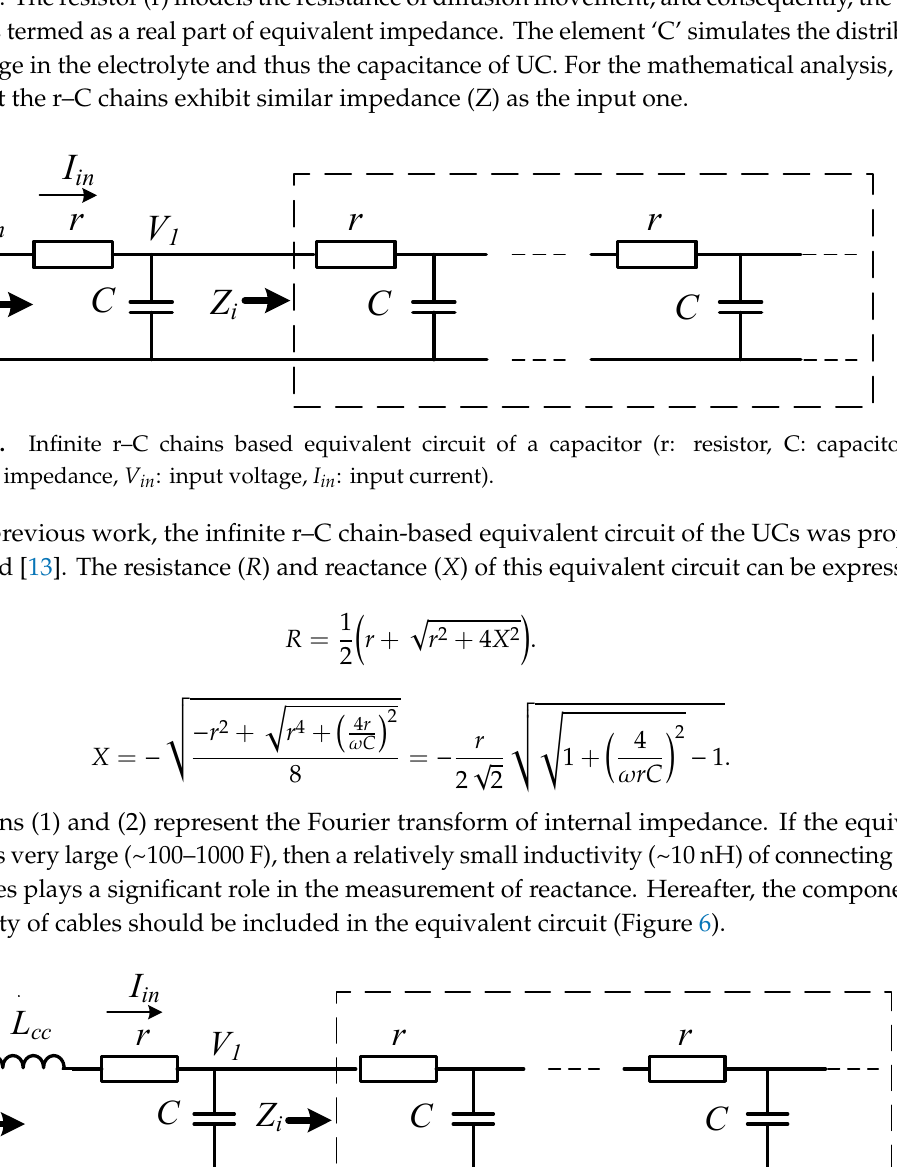
Figure 4. Phase ( θ ) of Z as a function of frequency ( a ) at different temperatures for constant voltage (~2.5 V) and ( b ) at different voltages for a constant temperature of 15 °C.